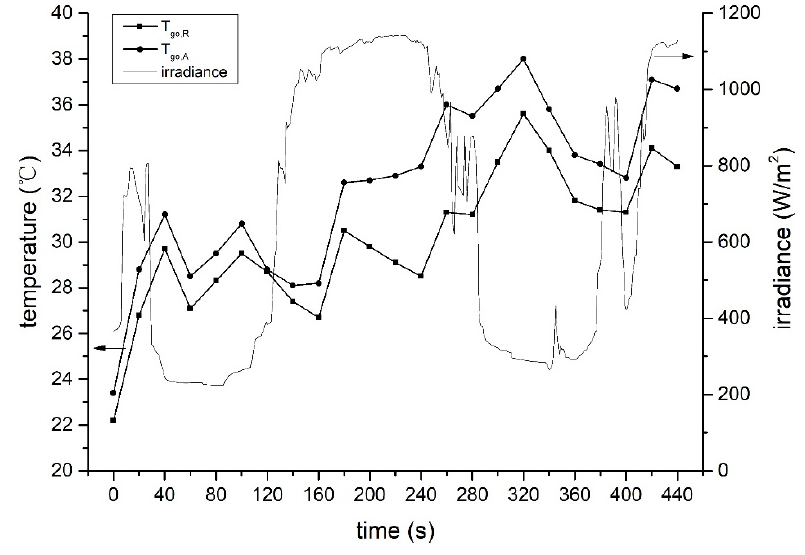
Figure 10. The change of the outer surface temperature of the cover plate with the fluctuation of solar irradiance.